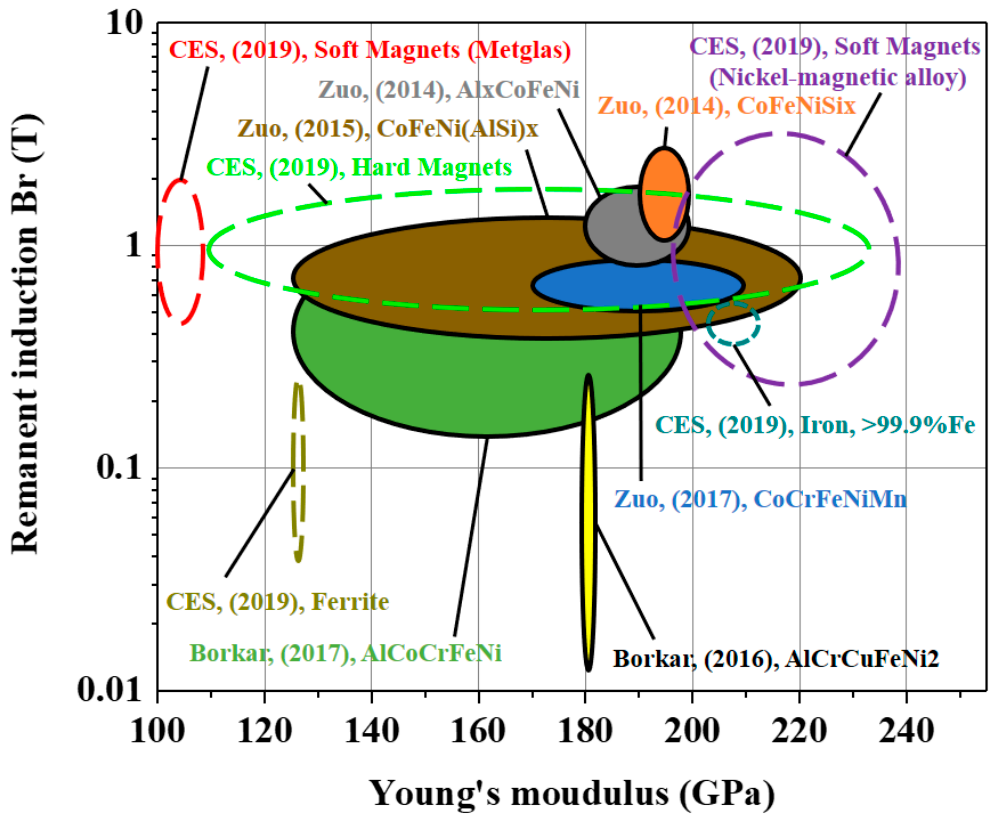
Figure 6. Remanent induction vs. Young’s modulus for conventional alloys (encircled by dashed lines) and HEAs (colored regions encircled by solid lines). (Data taken from [27,29,34,35,40,43,75,76,78,80]). The data is from the CES EduPack 2009, Granta Design, Limited, Cambridge, UK, 2009.